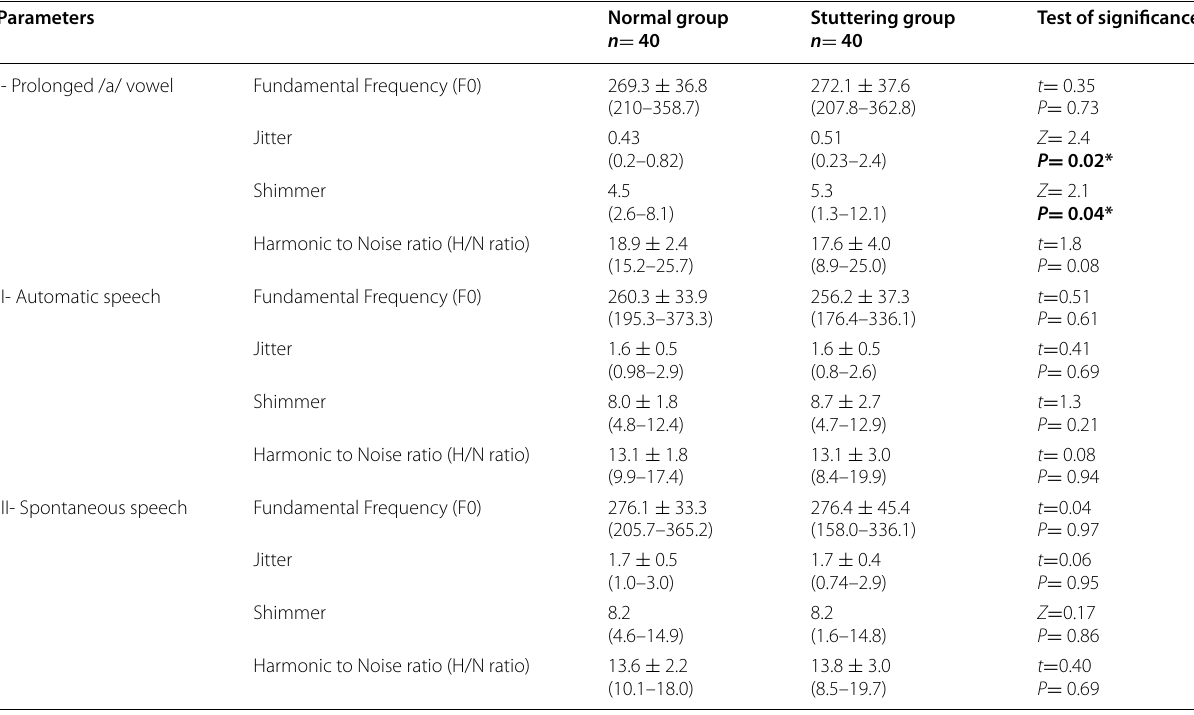
Table 3 Acoustic parameters of the normal and stuttering groups